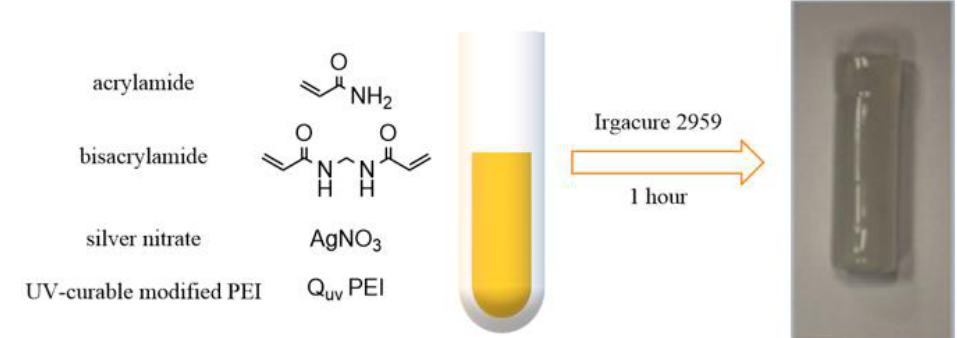
Figure 12. Schematic representation of the photoinduced formation of UV-curable cationic poly(ethyleneimine) (Quv-PEI)-based silver-loaded hydrogel. Reprinted with permission. Copyright 2016, Elsevier [44].